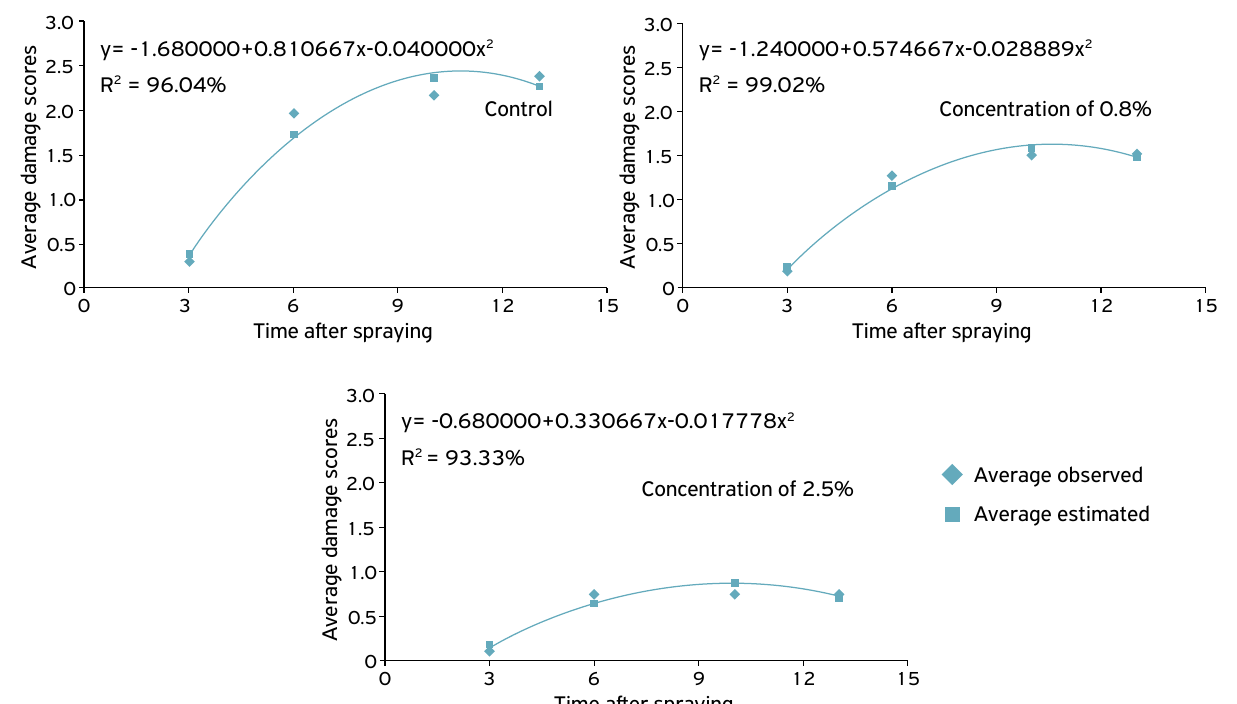
Figure 3. Average damage scores attributed to Spodoptera frugiperda feeding on corn plants sprayed with different concentrations of an aqueous extract of pequi ( Caryocar brasiliense ) fruit peels, separated by extract